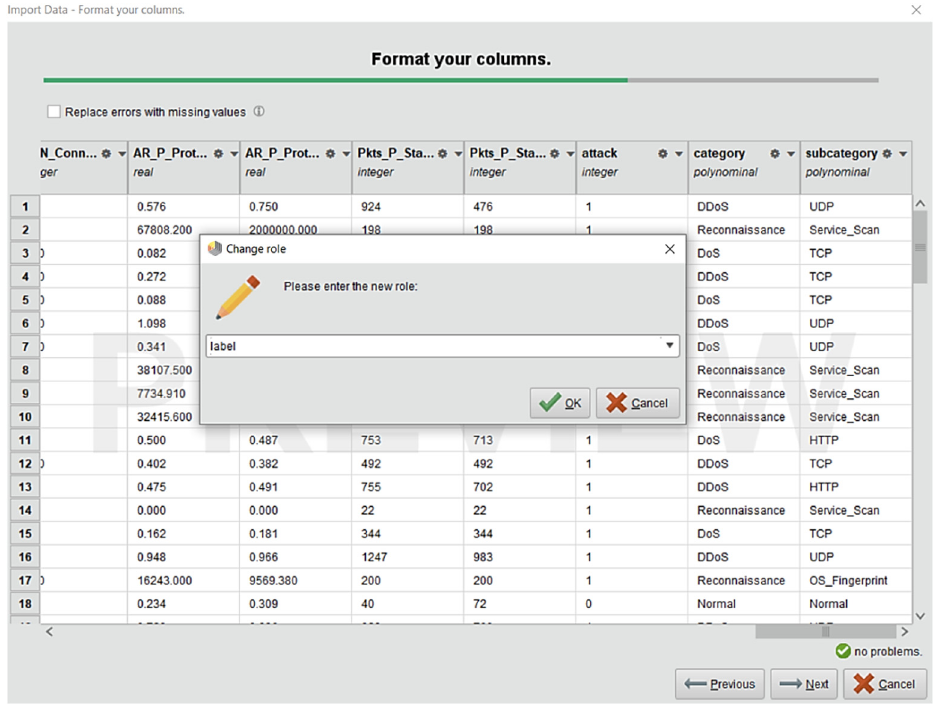
Figure 2. Data preprocessing in Rapidminer.